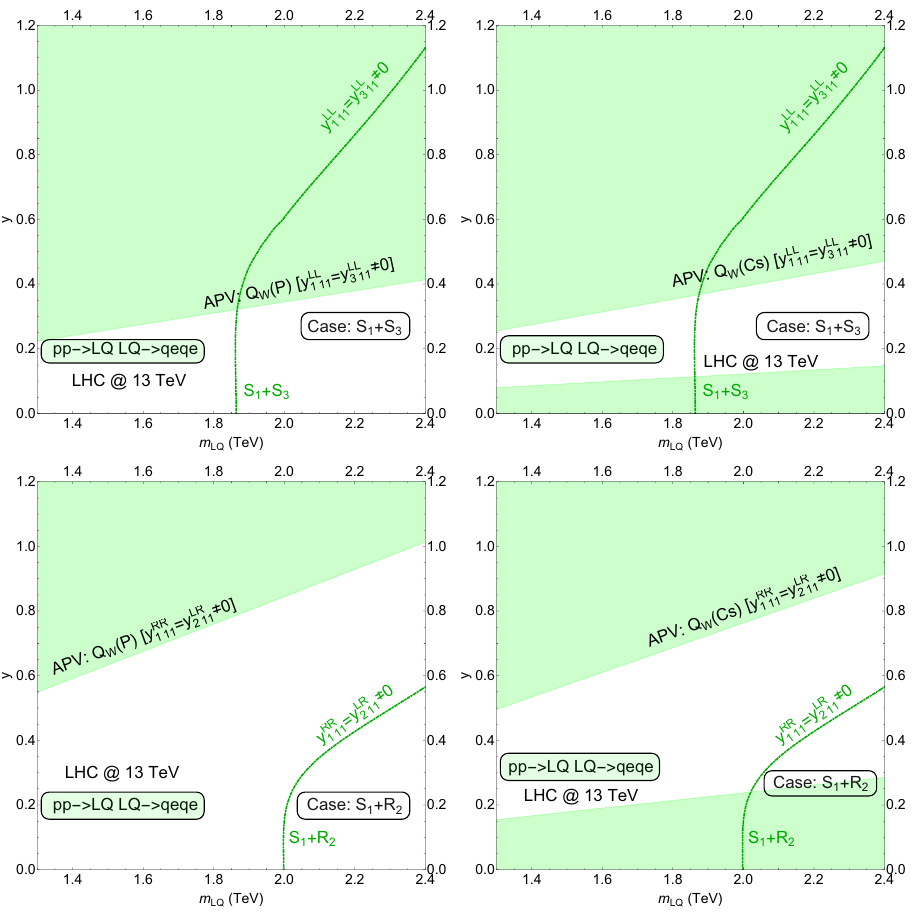
Figure 13 . APV limits for the proton (left) and Cs (right) measurements juxtaposed with the leptoquark pair production search limits for the corresponding leptoquark scenarios, as indicated. Shaded regions are ruled out by the APV